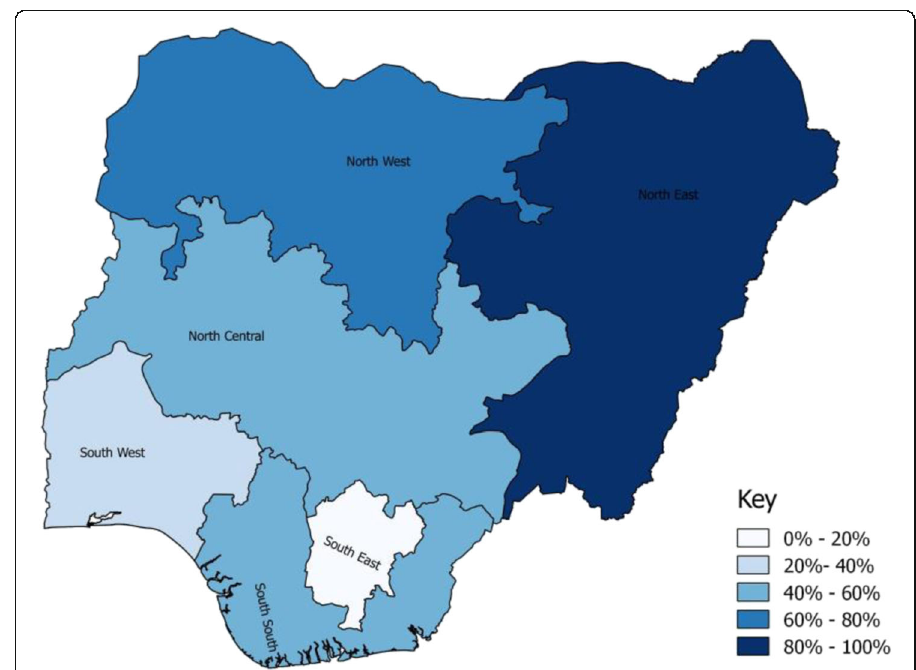
Fig. 2 Percentage of women believing that a husband is justified in beating his wife if she goes out without telling him, by region, NDHS 2003